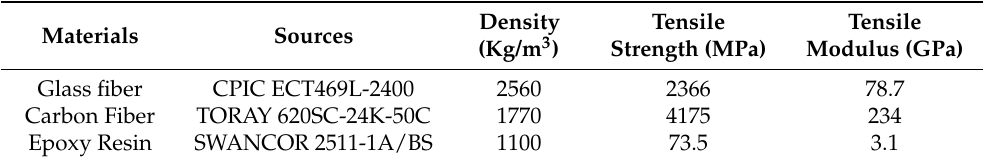
Table 1. Parameters of raw materials.